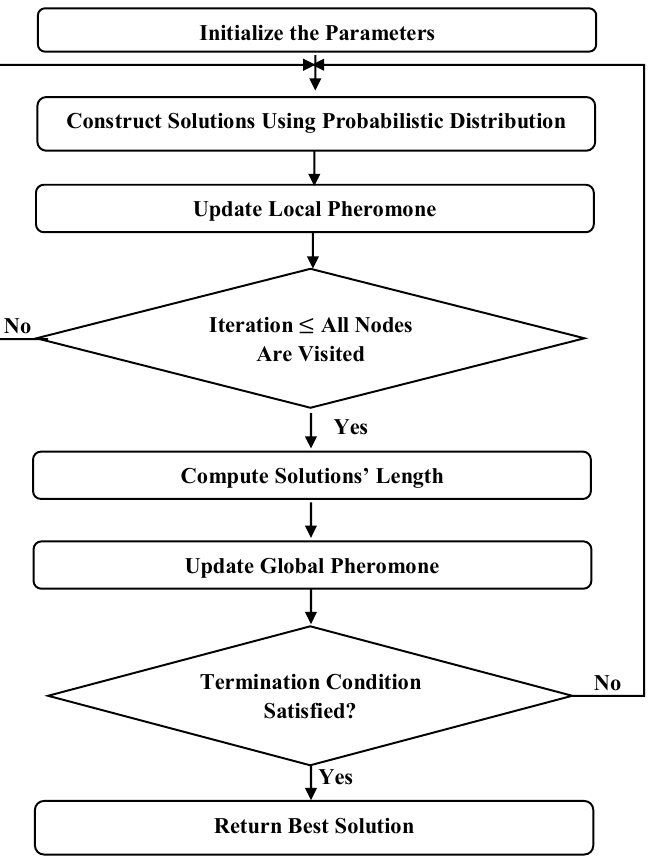
Figure 2. Ant colony optimization (ACO) flowchart.